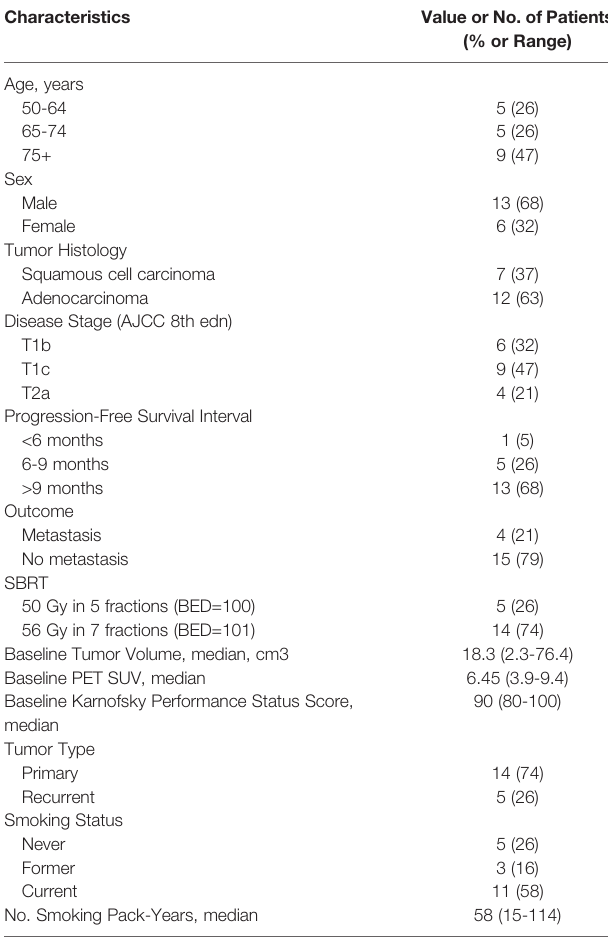
TABLE 1 | Clinical characteristics of the